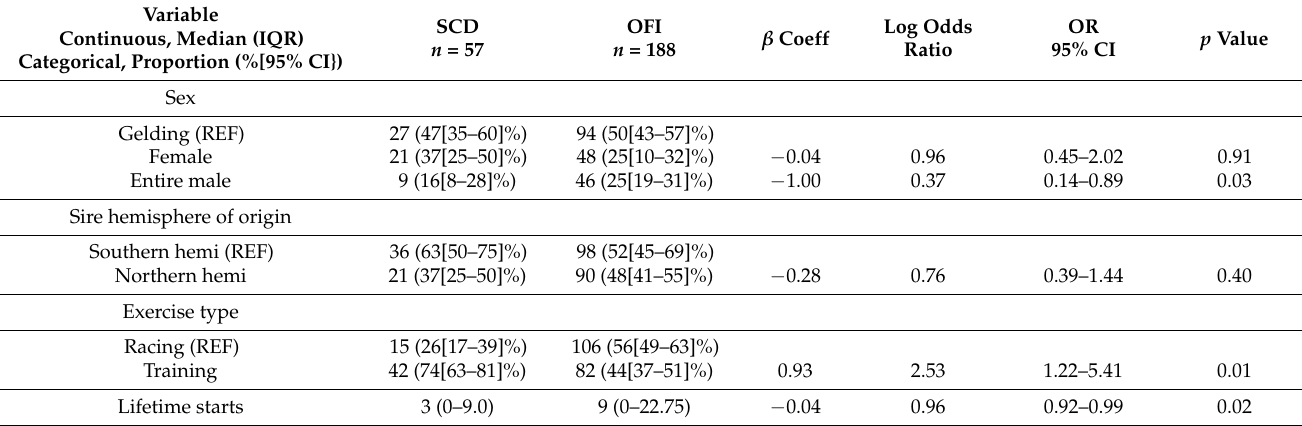
Table 2. Multivariable logistic regression of relationship between each included variable and